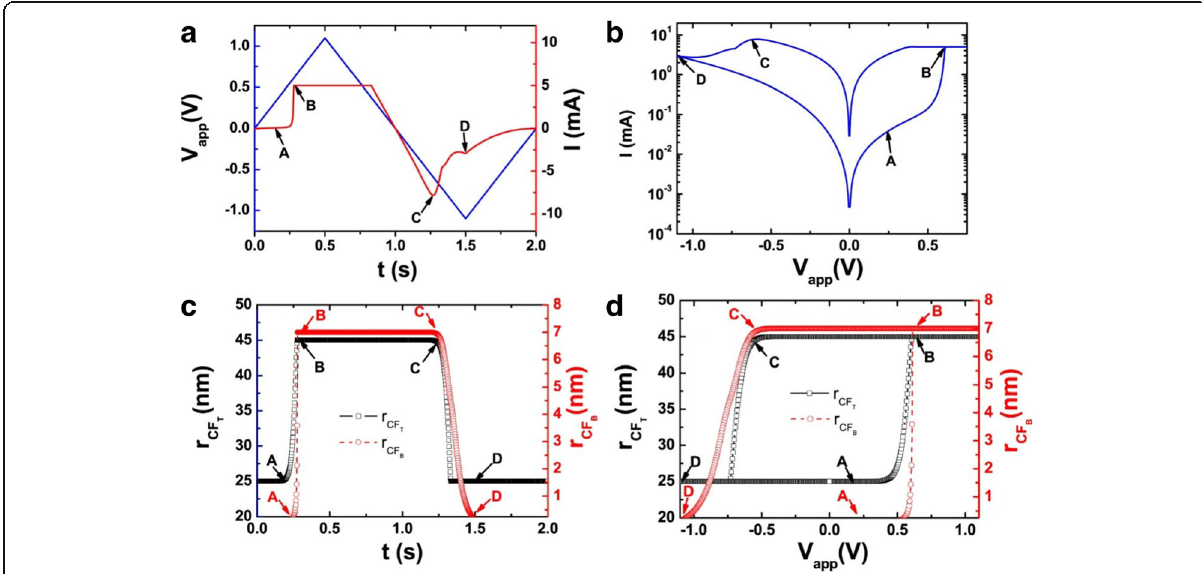
Fig. 16 a Applied triangular voltage signal (blue) and corresponding device current (red) versus time. b The RRAM current against the applied voltage. c Top and bottom CF radii versus time for the devices under consideration. d Top and bottom CF radii corresponding to figure 7(c) versus applied voltage